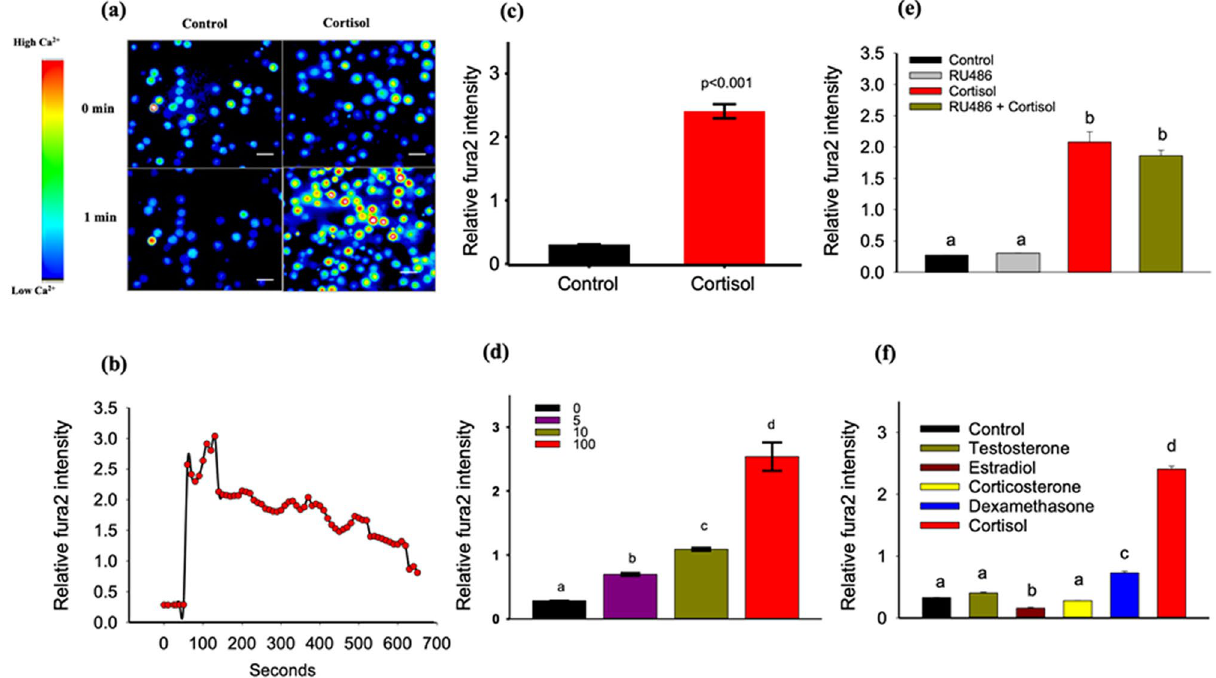
Figure 1. Cortisol rapidly stimulates ([Ca 2+ ]i). Hepatocytes incubated with ratiometric dye fura2 and with and without cortisol for 1 min. Enhanced dye intensity with cortisol was seen in > 75% of hepatocytes; scale bar represents an approximate cell diameter of 25 μm (field of view at 40x has1392 × 1040 pixel with 6.19pixel/μm) ( a ) Representative fluorescence images taken at 0 or 1 min either with or without the addition of cortisol. ( b ) Representative line graph showing the time-dependent fura2 intensity ([Ca 2+ ]i) changes in response to cortisol exposure. ( c ) Bar graph showing ([Ca 2+ ]i) changes at 60 s after cortisol addition (t test; p < 0.001). ( d ) Dose- related ([Ca 2+ ]i) response at 60 s to cortisol (0, 5,10 and 100 ng/ml). ( e ) Bar graph showing ([Ca 2+ ]i) changes at 60 s in response to either control, RU486, cortisol or cortisol + RU486. ( f ) Bar graph showing ([Ca 2+ ]i) changes at 60 s in response to either control, testosterone, estradiol, corticosterone, dexamethasone and cortisol exposure. All bars represent mean ± SEM (n = 5–6 fish; ~ 100 cells from each fish); Bars with different letters are significantly different (one-way ANOVA; p <